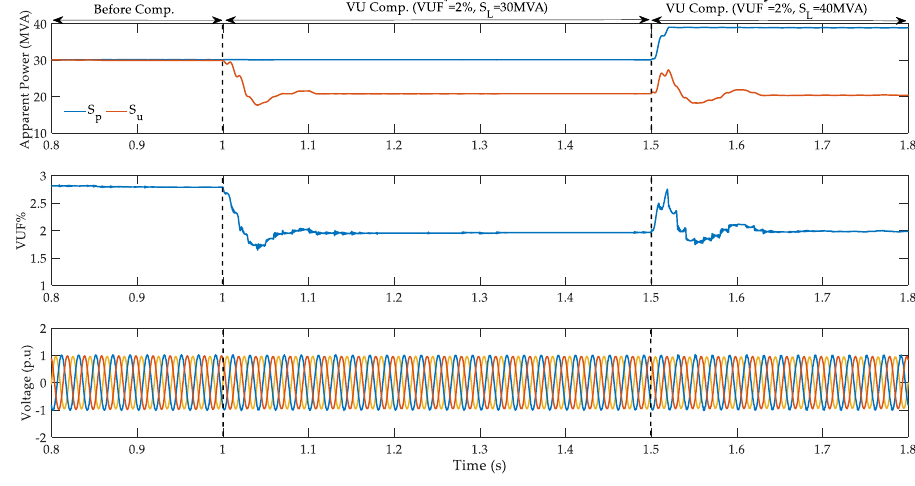
Figure 18. Simulation results of unbalanced compensation performance.